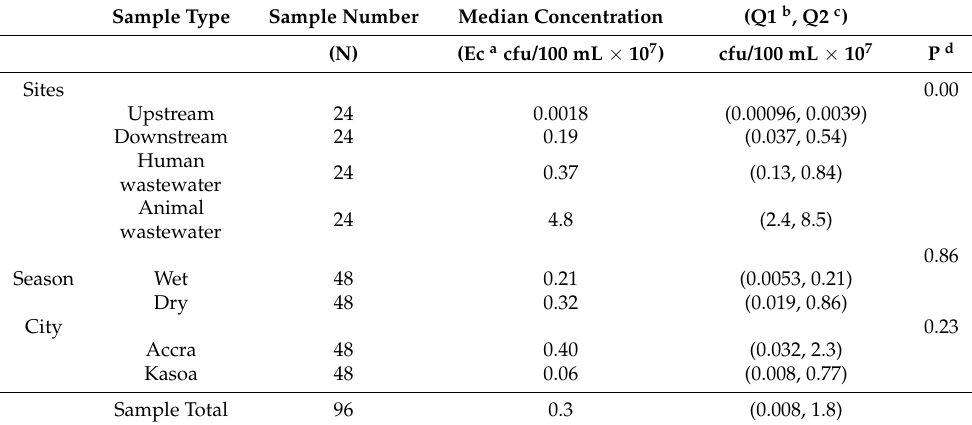
Table 2. Concentrations of Escherichia coli (Ec), stratified by site, city, and season in water samples